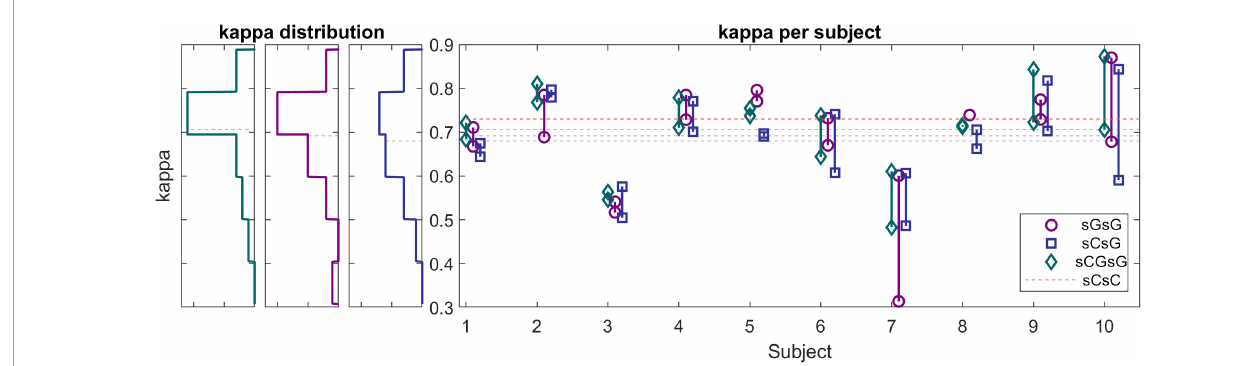
FIGURE6 (Left panels) Histograms of kappa values for sG recordings (cross-validation scheme: sGsG: purple, sCsG: blue, sCGsG: green). Dashed lines represent the average of each method. For the sGsG and sCGsG schemes, the majority of the recordings yielded a kappa value above 0.7. (Right panel) Kappa values for each subject for all three cross-validation schemes. Each point represents one recording.